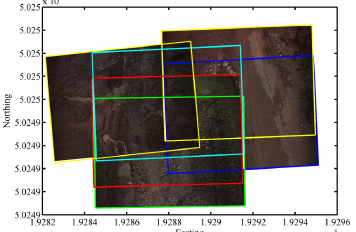
Figure 11. The approximate fields of view of cameras